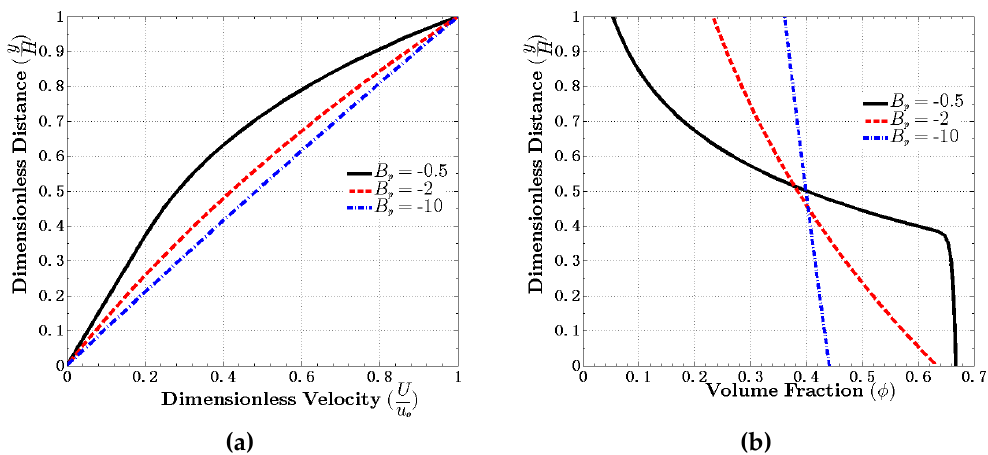
Figure 4. The effect of (2𝑀 (cid:2869) + 𝑀 (cid:2870) ) on the velocity profile ( a ) and the volume fraction profile ( b ), when